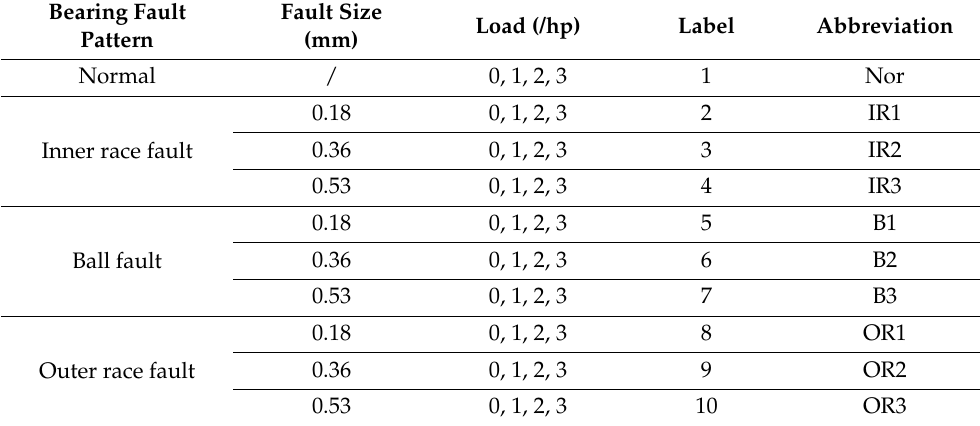
Table 1. Composition of the